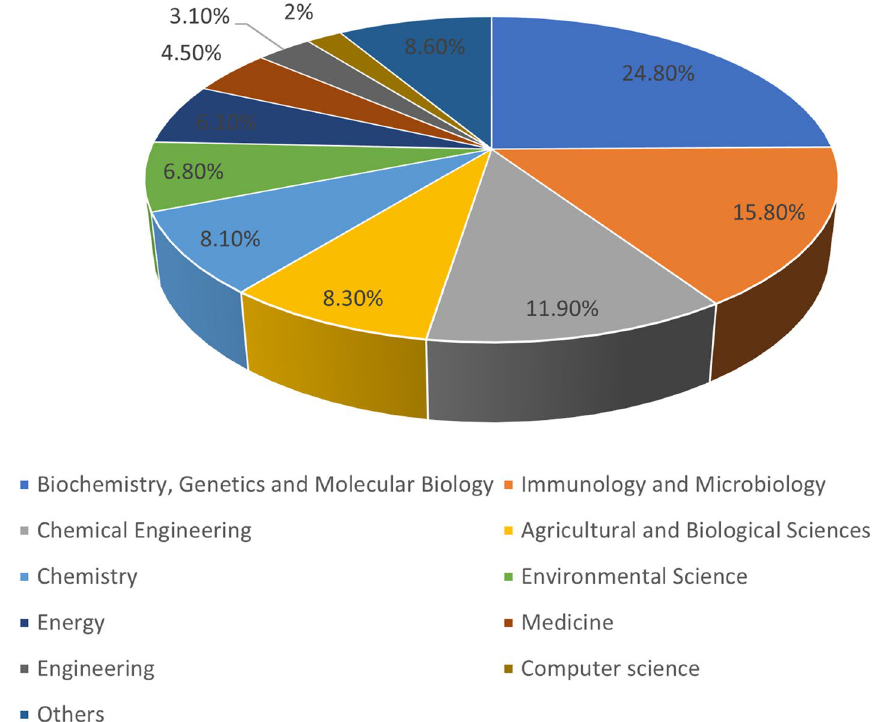
Fig. 2 The main research topic related to thermostable enzymes